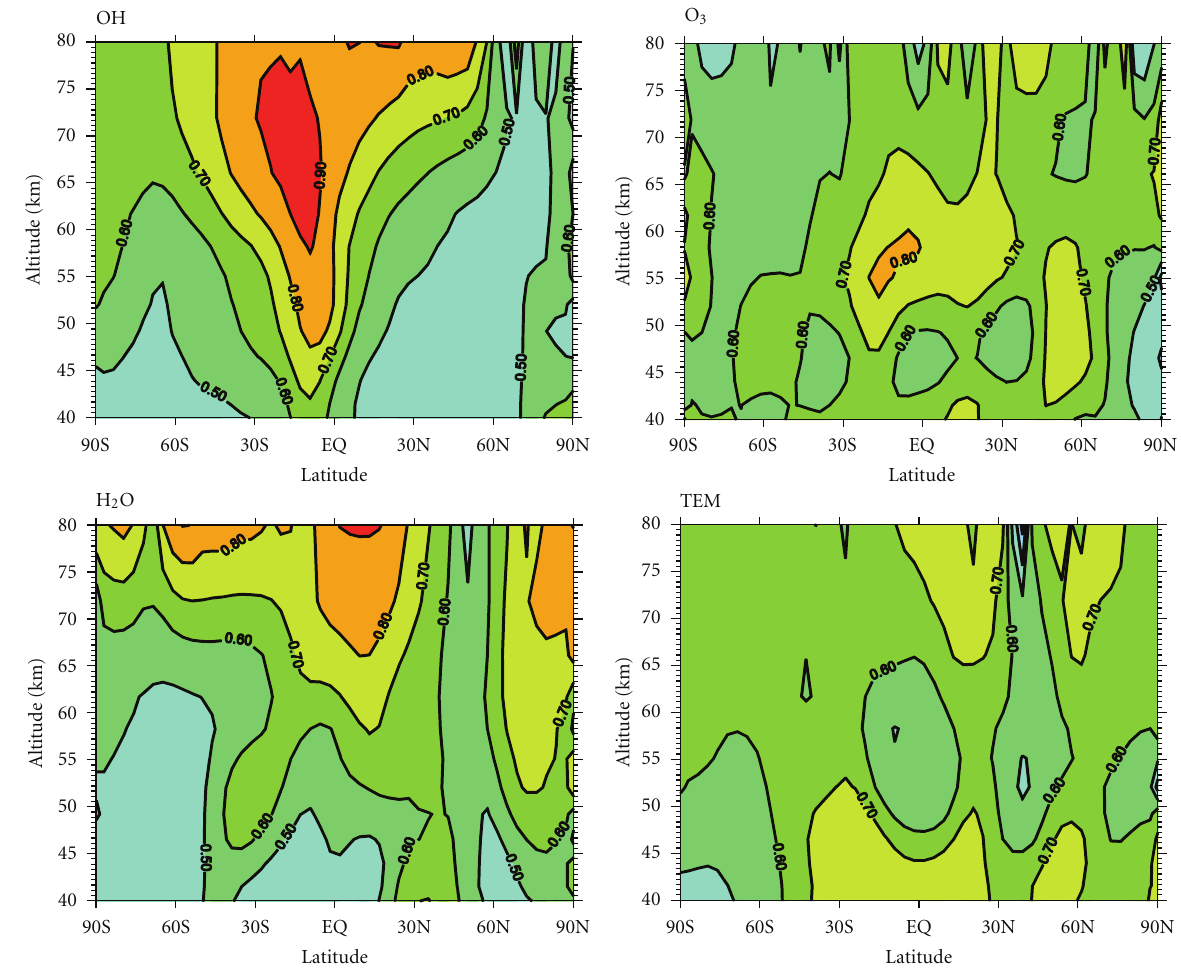
Figure 2: Maximum of the cross-correlations between simulated ensemble mean quantities and solar irradiance at